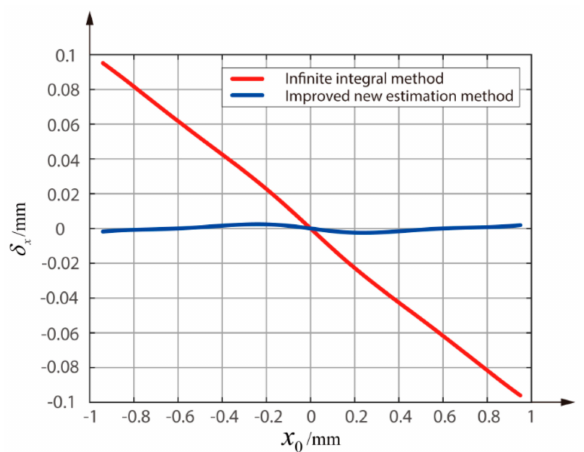
Figure 8. Comparison of the errors between the improved new estimation method and the infinite integral method when ω is 0.95 mm.